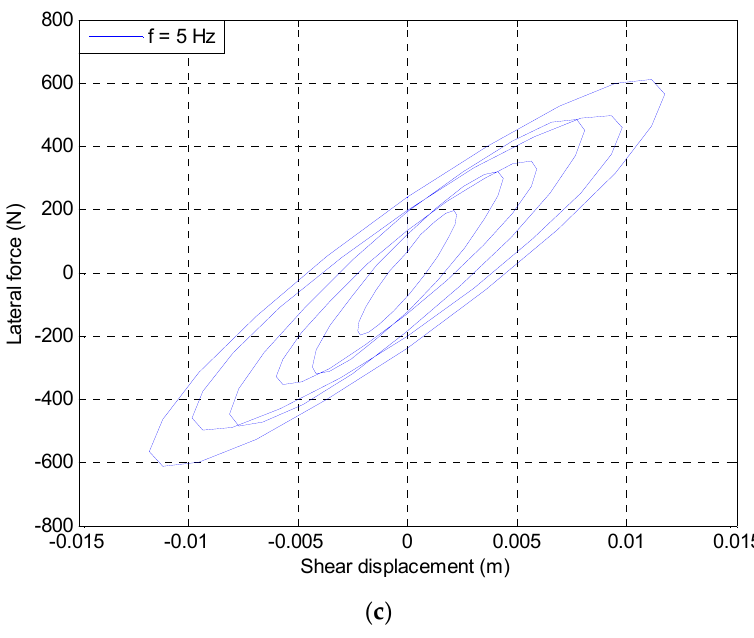
Figure 3. Experimentally obtained hysteresis loops at excitation frequencies of 1 Hz ( a ); 2 Hz ( b ); and 5 Hz ( c ). Table 1. Average equivalent damping ratios.